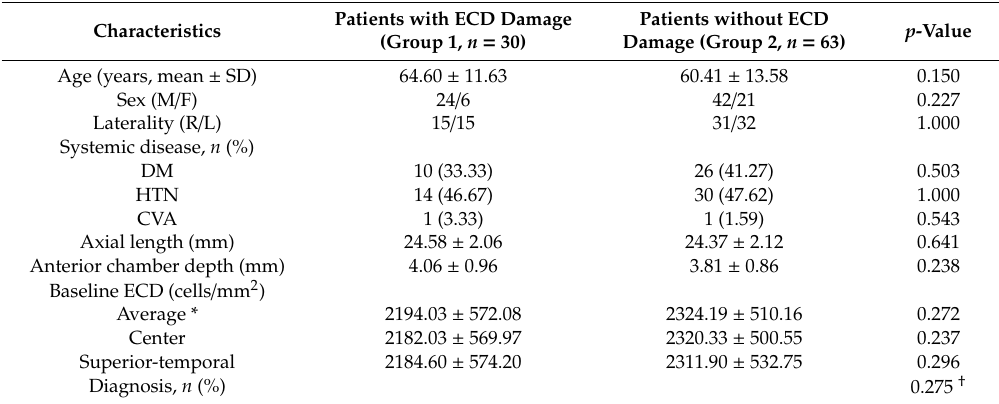
Table 1. Characteristics of the